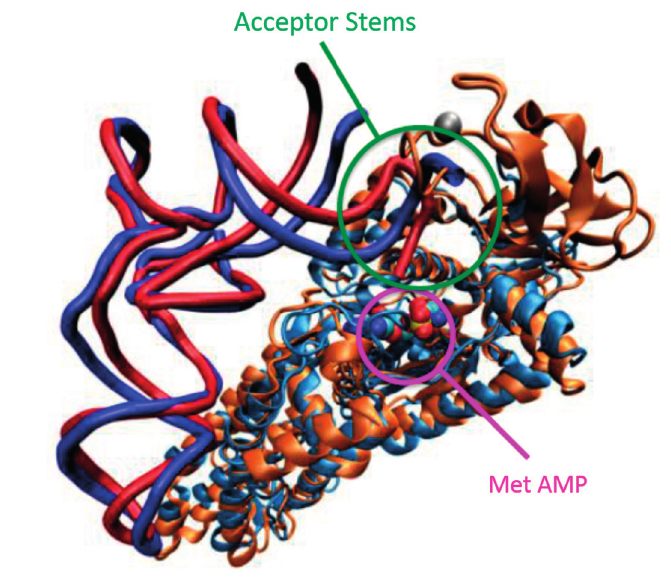
Figure 7. Structure of modeled E. coli MetRS:tRNA fMet complex with hairpinned and extended tRNA 3 ʹ -end. The A. aeolicus MetRS:tRNA Met complex (light blue and dark blue) is superimposed with the E. coli MetRS structure (orange) such that the MetRS structures are aligned. The E. coli tRNA fMet (red) with a hairpinned 3 ʹ -end is structurally aligned to the A. aeolicus tRNA Met structure to complete the modeled E. coli MetRS:tRNA fMet complex. The Zinc (silver) and Met-AMP are shown in space-filled representation. Note the proximity of the tRNA fMet hairpinned 3 ʹ -end to the Met-AMP, the substrate for the aminoacylation